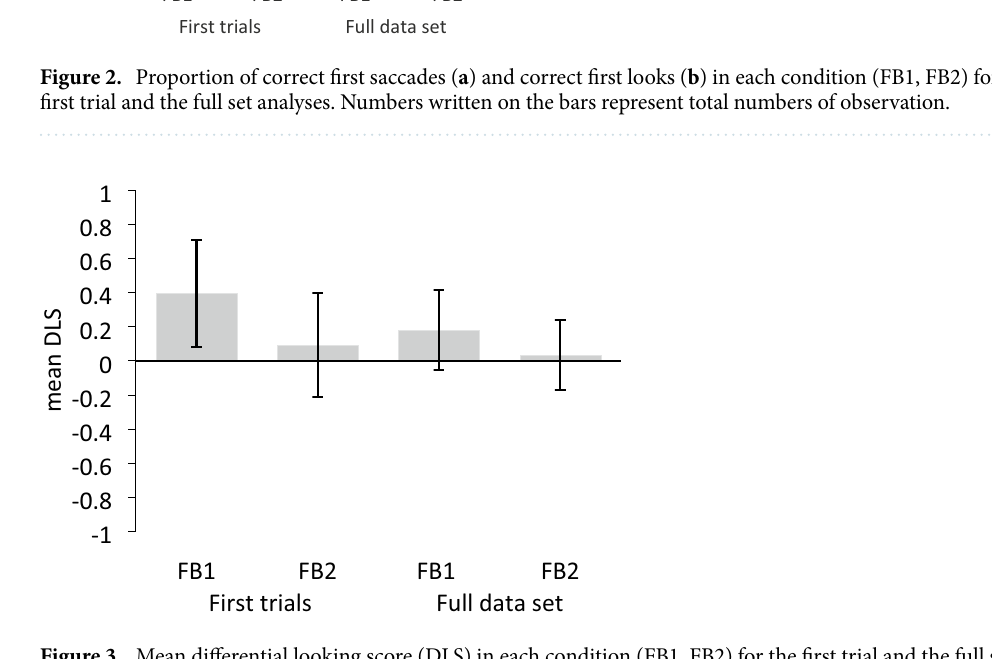
Figure 3. Mean differential looking score (DLS) in each condition (FB1, FB2) for the first trial and the full set analyses. Error bars depict 95% confidence